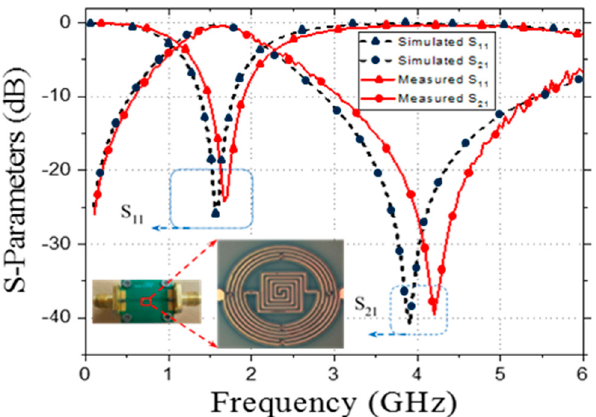
Figure 5. Simulated and measured S-parameters and the pictures of the fabricated resonator.